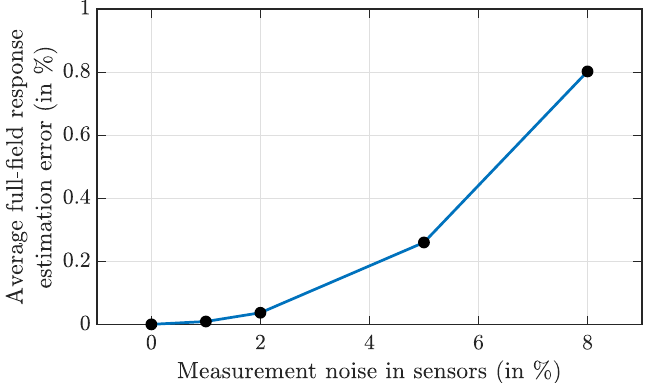
Figure 7. Average full-field response estimation error for the measurement